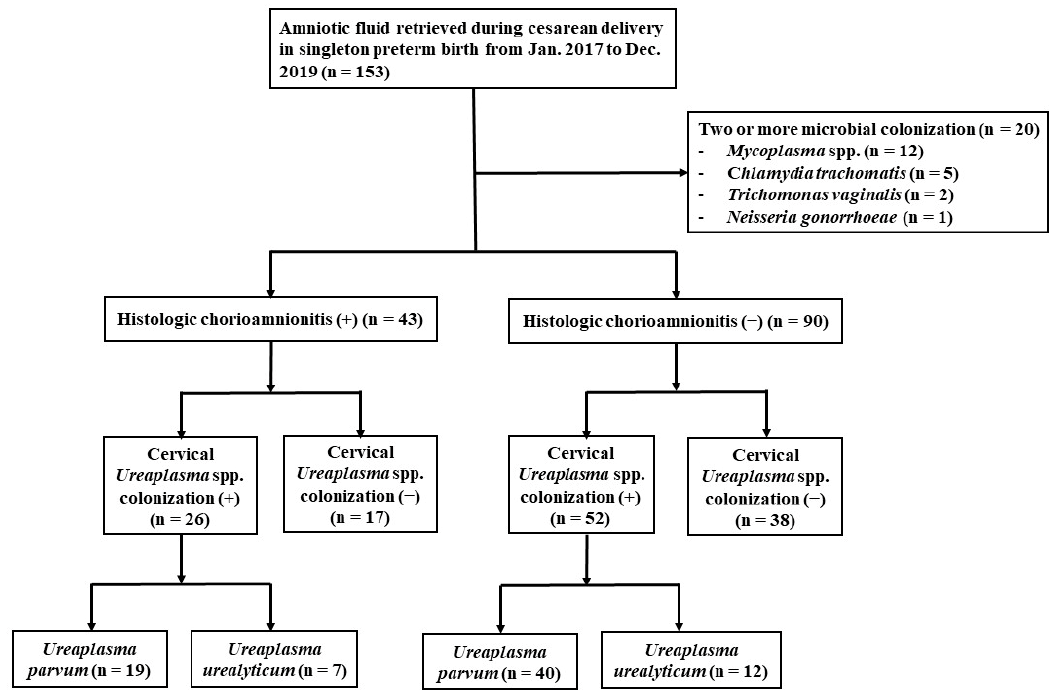
Figure 2. A flowchart of the study.